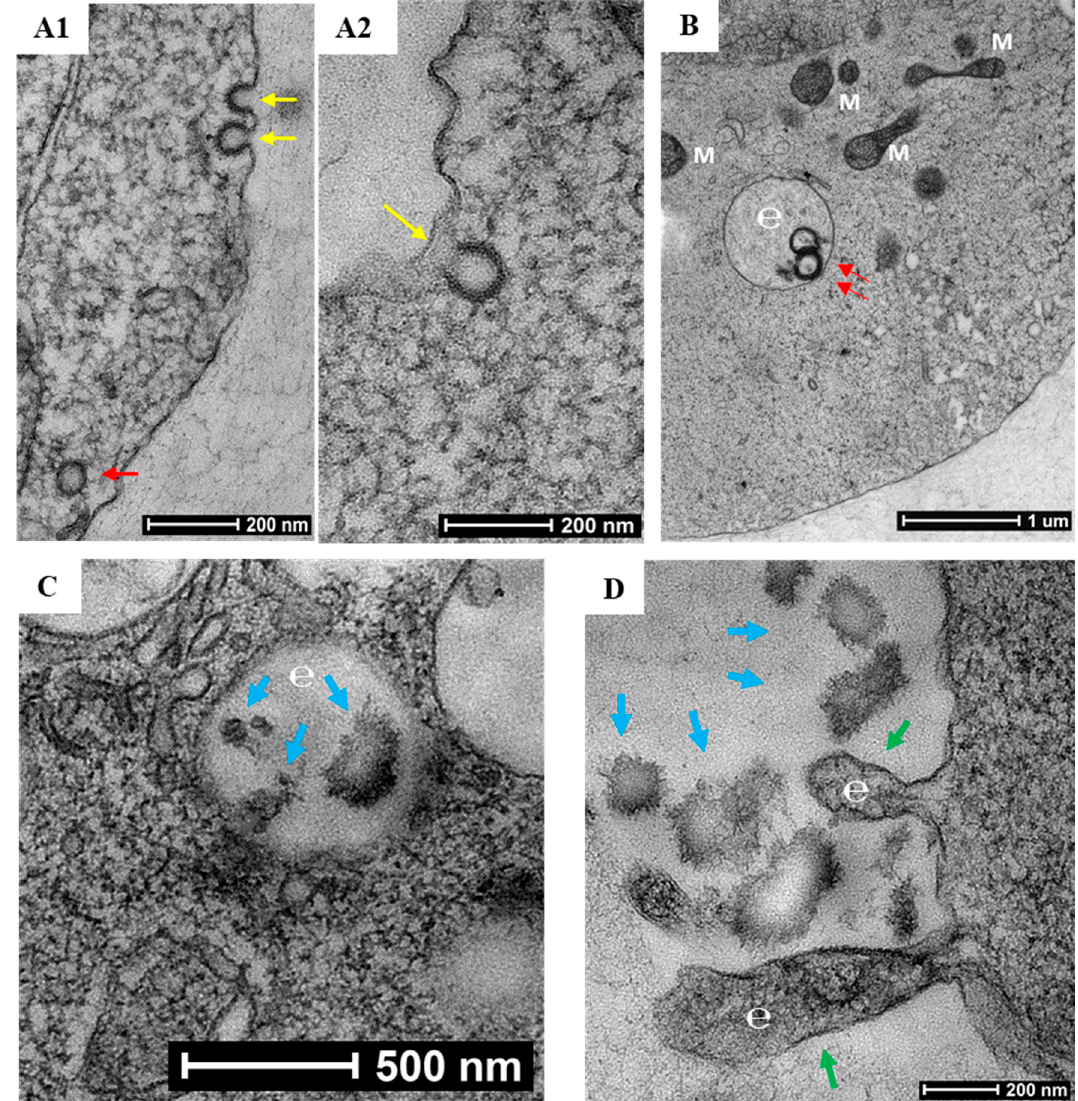
Figure 3. Electron micrographs of biomineralization. K562 cells were cultured for 72 h in MEM α containing 10% FBS, α GP (2 mM), and CIP (1 U / mL). ( A1–2 ) Formation of caveolae (yellow arrows) initiated endocytosis of mineral matrix at the cytoplasmic membrane. ( B , C ) Caveolar endocytosis (red arrows) transported the mineral matrixes to the endosomes (e), where calcium phosphate agglomerates were synthesized (blue arrows; M = mitochondrion). ( D ) Endosomes (e) budded from the cell membrane (green arrows) to release the mineral agglomerates (blue arrows) into the extracellular space. Bars indicate various scales within the images.